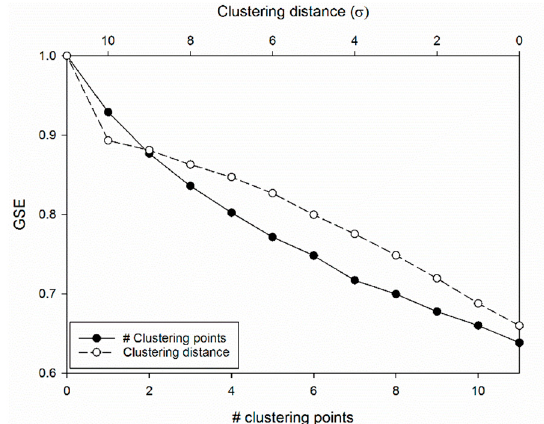
Figure 5. The variation of GSE with the number of clustering points ( σ = constant; filled symbols) and the standard deviation of the distribution of clustering points ( n c = constant; clustering distance (open symbols). Conditions close to CSR will only occur at σ » 10, leading to the discontinuity for the clustering distance graph at σ = 10. In both cases, q has been set constant to 6 × 8 = 48.